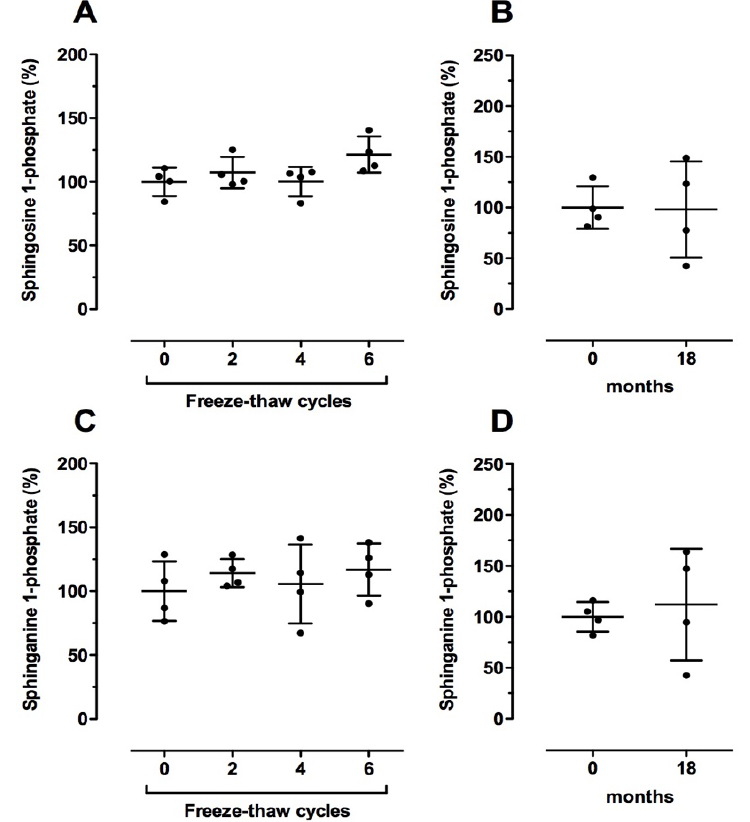
Figure 5. Effect of storage conditions on relative sphingosine 1-phosphate ( A , B ) and sphinganine 1-phosphate ( C , D ) levels in human blood samples. ( A – D ) Plasma was directly separated from blood (EDTA as anticoagulant) as described in the Material and Methods section. ( A , C ) Plasma samples were deep frozen at − 80 °C for 1 h and completely thawed at +22 °C for 30 min for the indicated number of freeze–thaw cycles. ( B , D ) Plasma samples were stored for 18 months at − 80 °C before analysis. Plasma without freeze–thaw cycles ( A , C ) or long-term storage ( B , D ) served as the respective controls (100%). Data are shown as the mean (in %) ± SD ( n = 4).